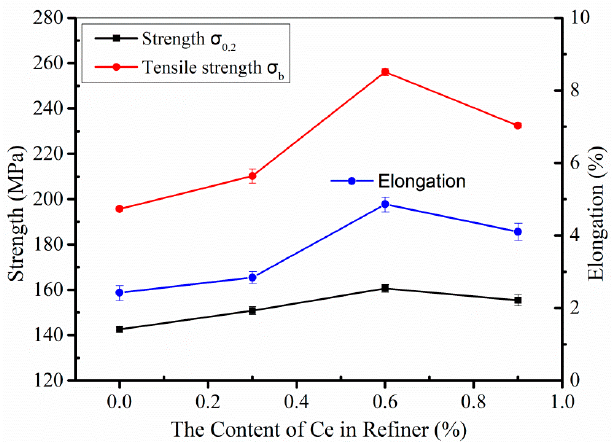
Figure 11. The tensile properties of the Al–Si alloy. Table 2. The tensile test results of aluminum silicon alloy after refining.